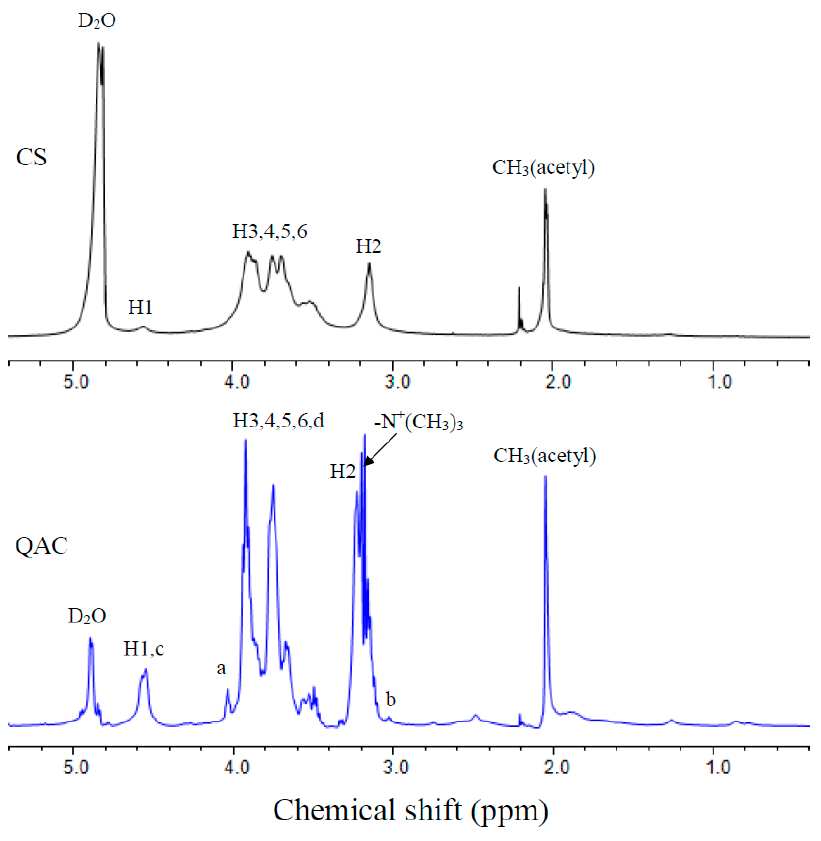
Figure 2. 1 H NMR spectra of CS and QAC.